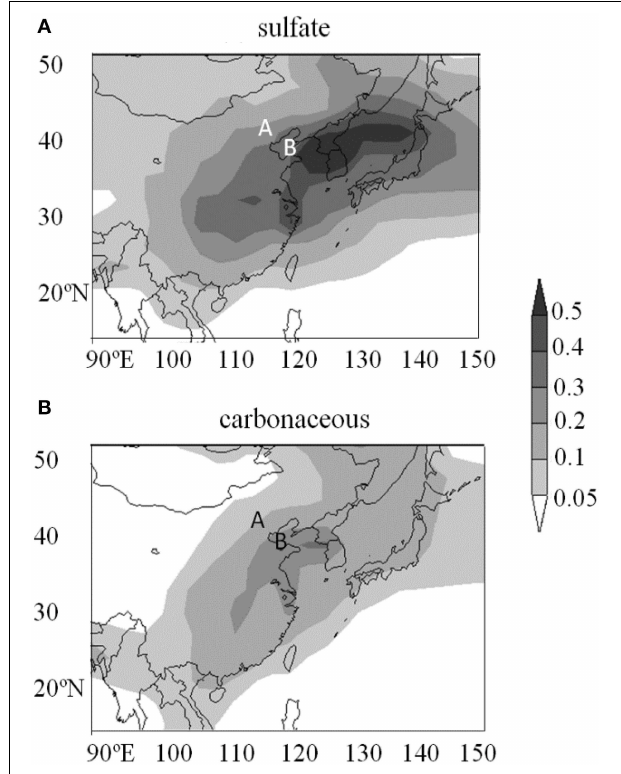
FIGURE 6 | Results of numerical model simulations with MIROC5.0 at a wavelength of 0.55 µ m in June in 2012. (A) Distribution of simulated monthly mean sulfate AOT components. (B) The same as (a) but for carbonaceous